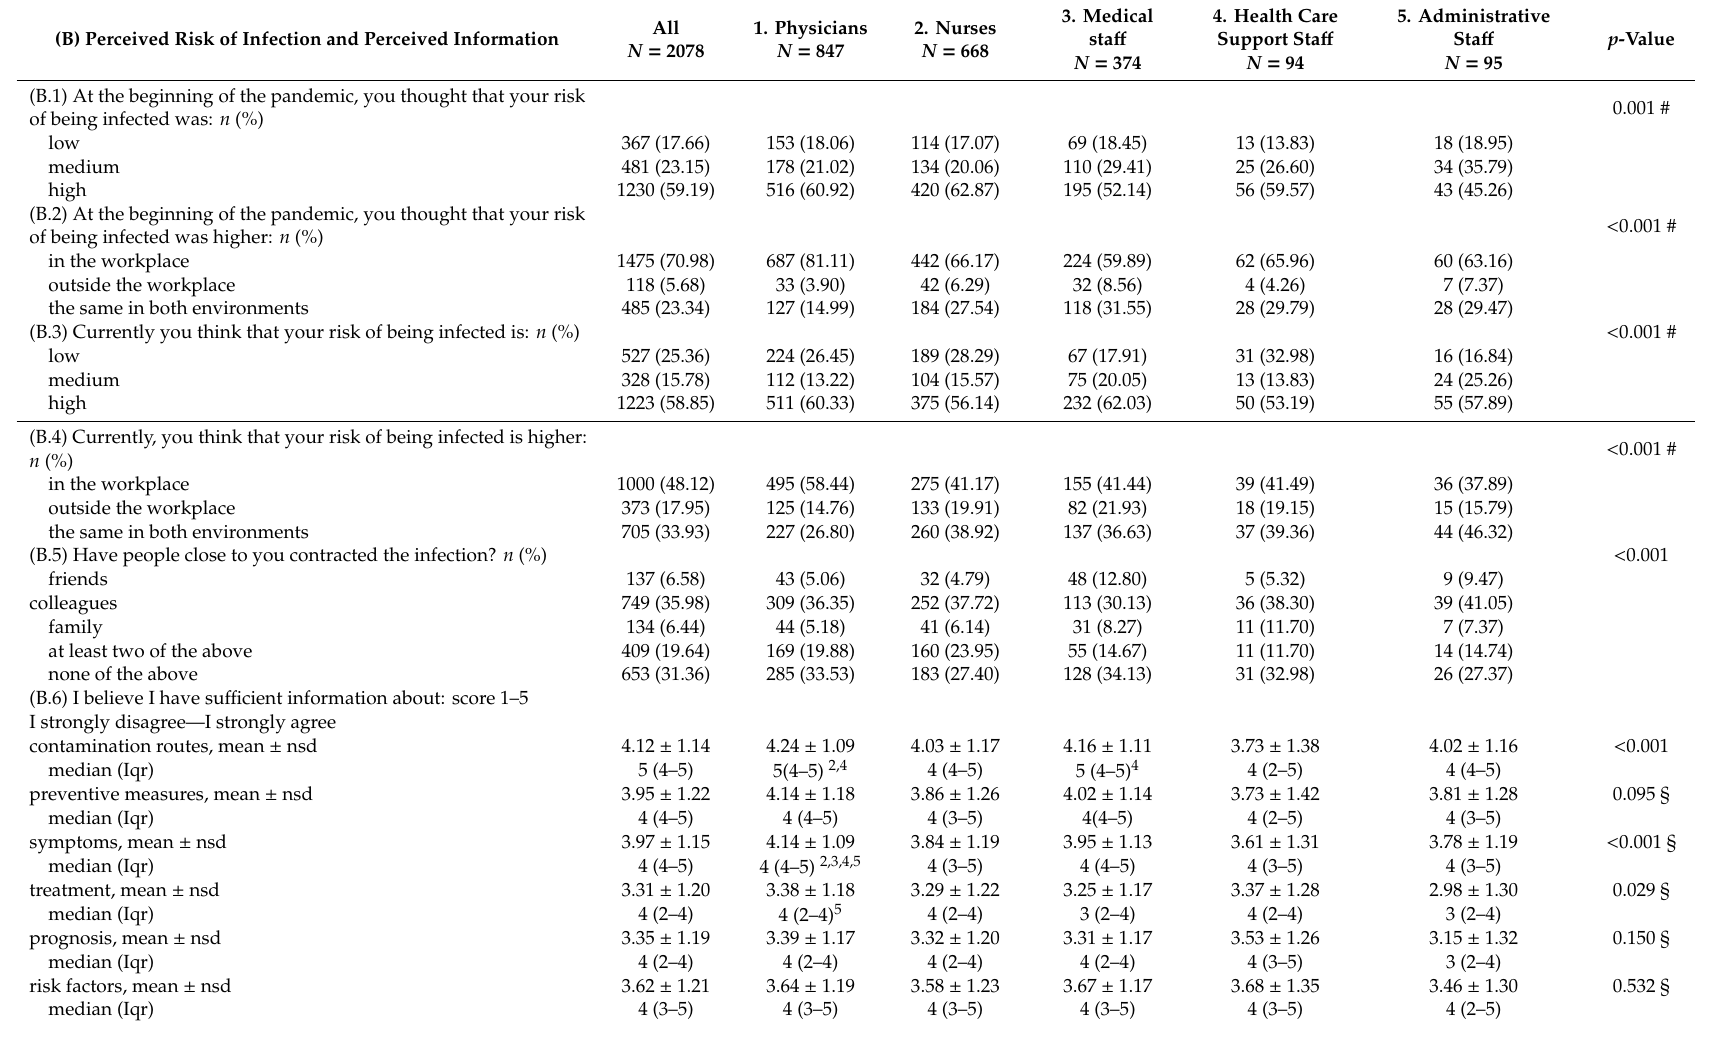
Table 3. Health care workers’ perceived risk of infection and perceived information about COVID-19